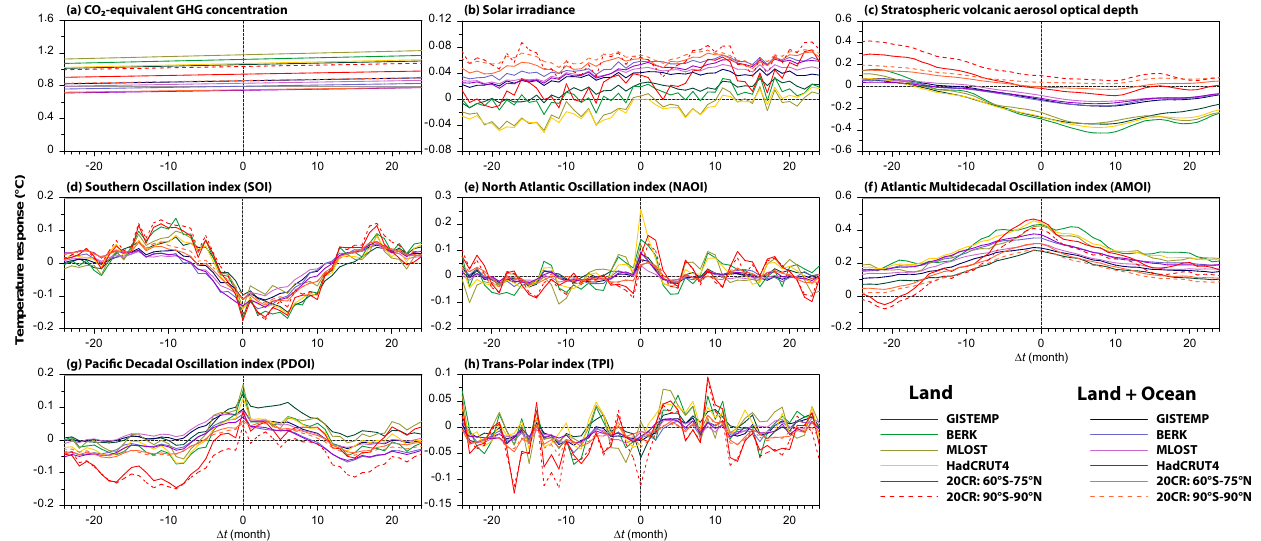
Figure 3. Temperature responses ( ◦ C) to characteristic variations of the explanatory variables (specified in Fig. 1), obtained by multiple linear regression carried out with one predictor shifted in time by (cid:49)t , while keeping the others at (cid:49)t =